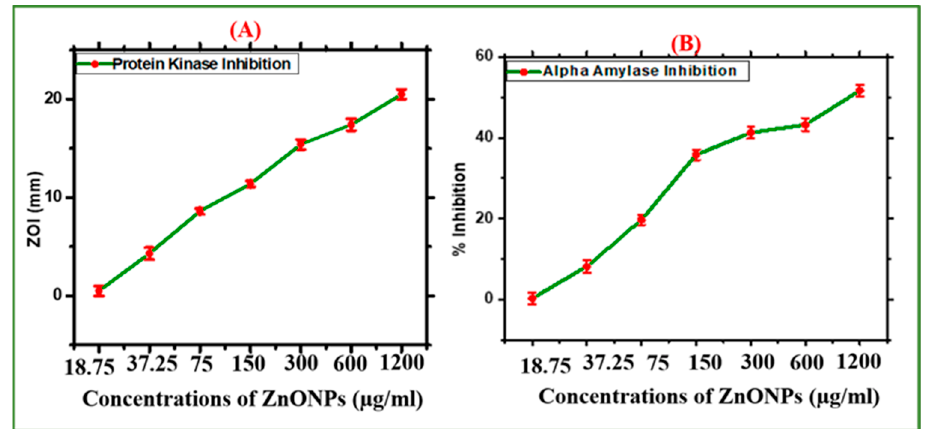
Figure 8. Enzyme inhibition potential of biosynthesized zinc oxide nanoparticles. The data in all figures represent the mean of three replicates. ( A ) Protein kinase inhibition; ( B ) α -amylase inhibition.